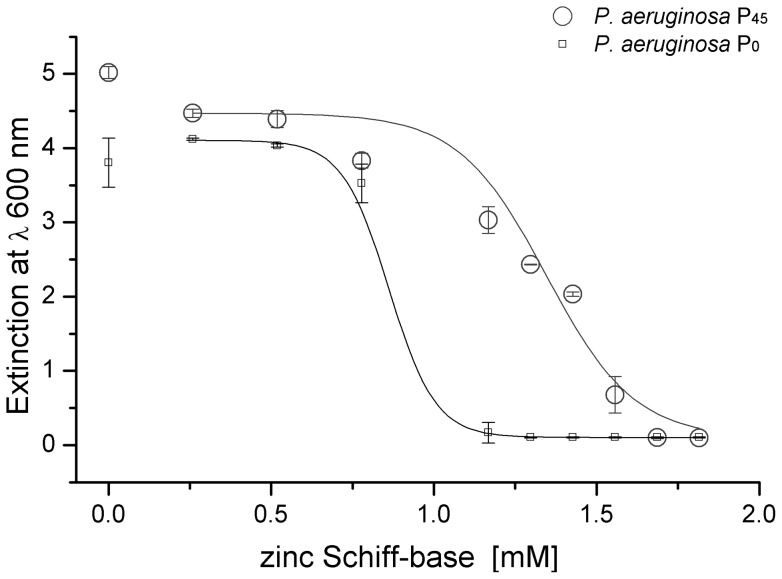
Comparison of growth of the ZSB adapted (P45) and the non-adapted (P0) P. aeruginosa PAO1. LB medium containing 2% (v/v) DMSO was used as control. A non-linear fit algorithm by dose-response function with variable Hill slope was used to fit both curves.